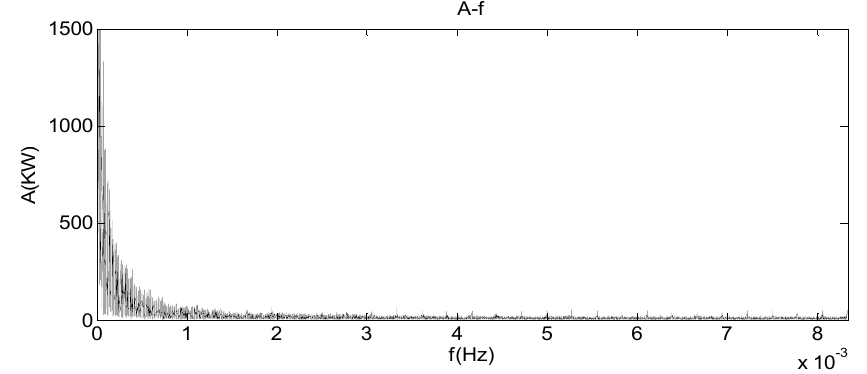
Figure 8. The amplitude frequency characteristic of the output power from a wind farm.